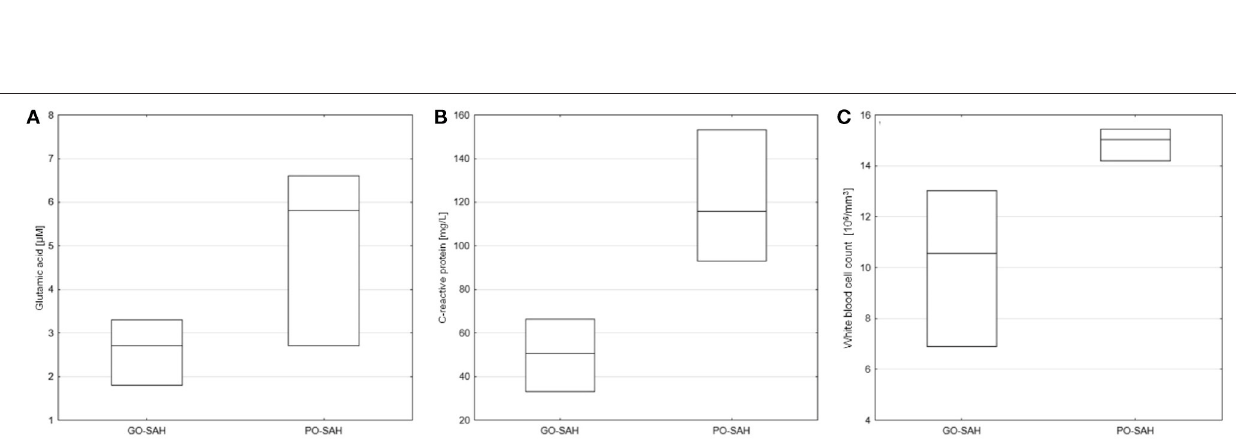
Frontiers in Neurology | www.frontiersin.org